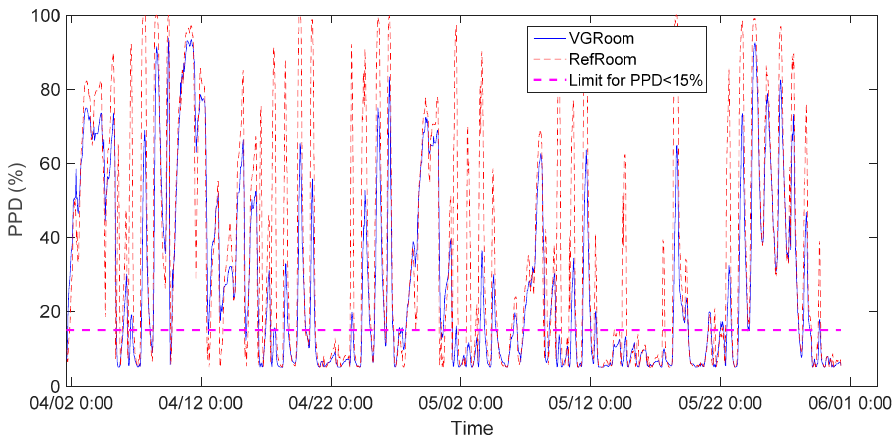
Figure 17. PPD values during the experiment.